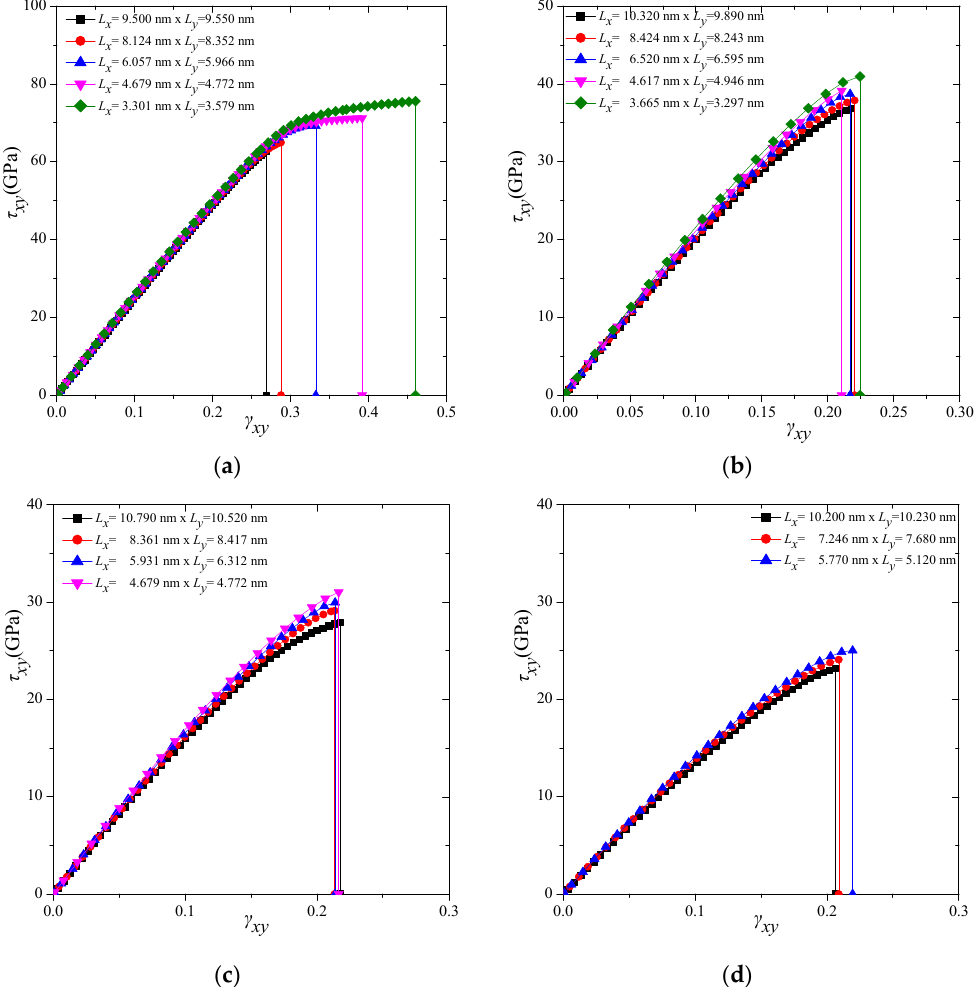
Figure 3. Shear stress–strain response of ( a ) graphyne, ( b ) graphdiyne, ( c ) graphyne-3, and ( d ) graphyne -4 structures in x–y direction.